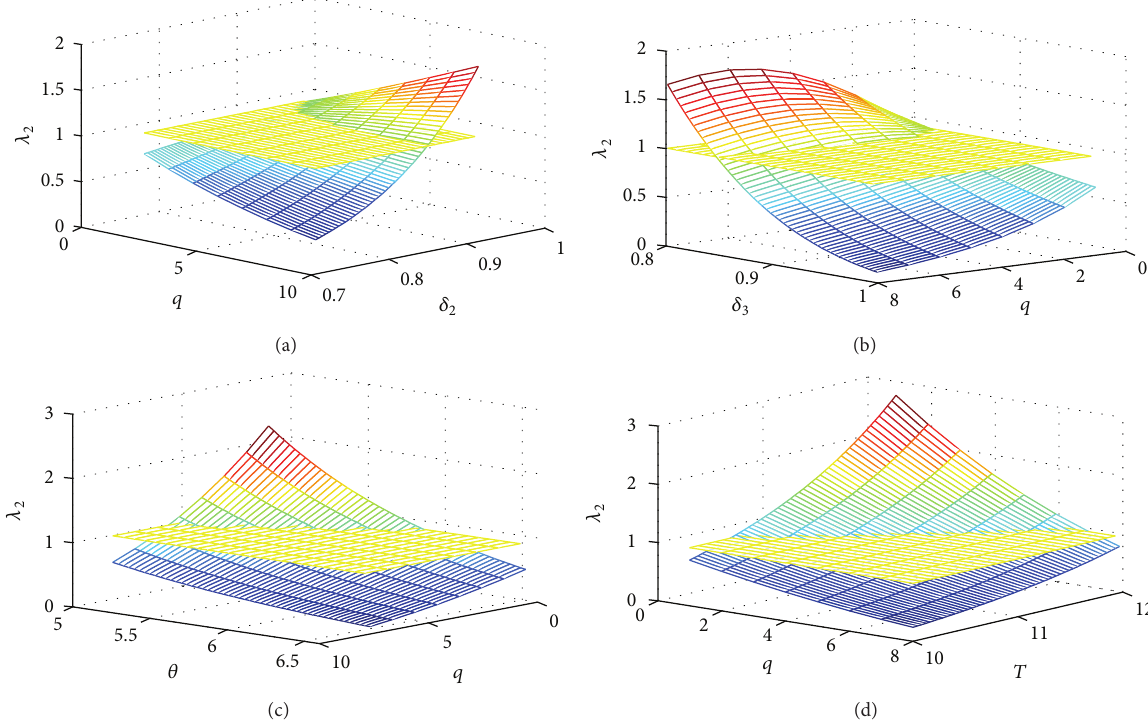
Figure 6: The effects of times of spraying pesticides and parameter sets on the threshold level 𝜆 2 . The parameter values are as follows: 𝑎 1 = 0.8 , 𝑑 = 0.25 , 𝑟 = 1.2 , 𝑐 = 0.3 , and 𝛼 and 𝑇 = 10 .